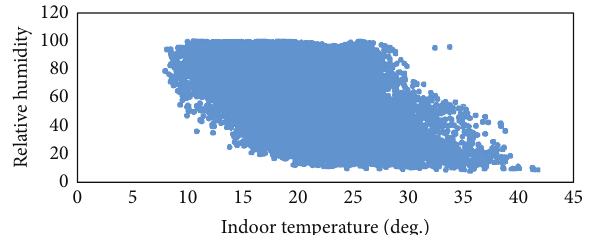
Figure 9: Variation of the indoor temperature with outdoor relative humidity.